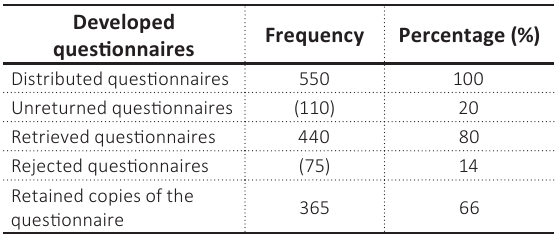
Table 1. Questionnaire distribution and